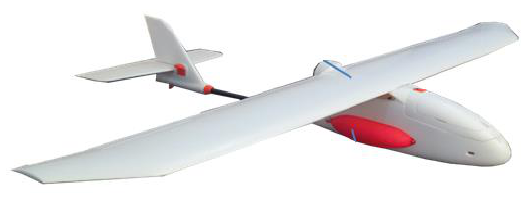
Figure 1 UAV fixed